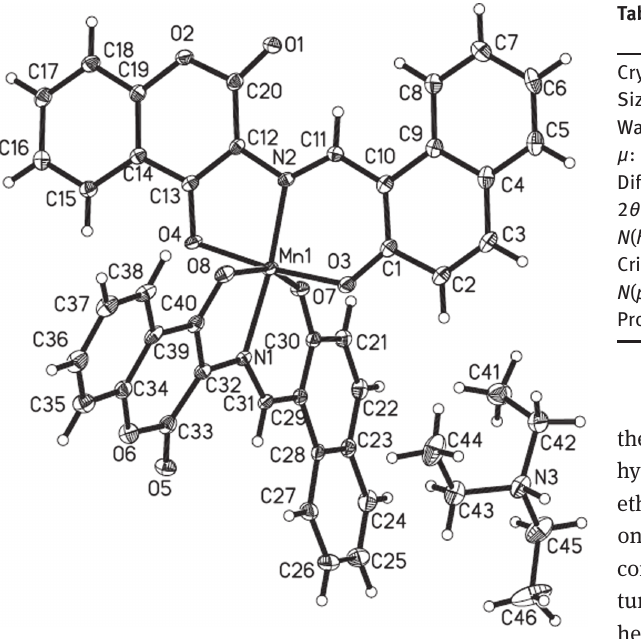
Table 1: Data collection and